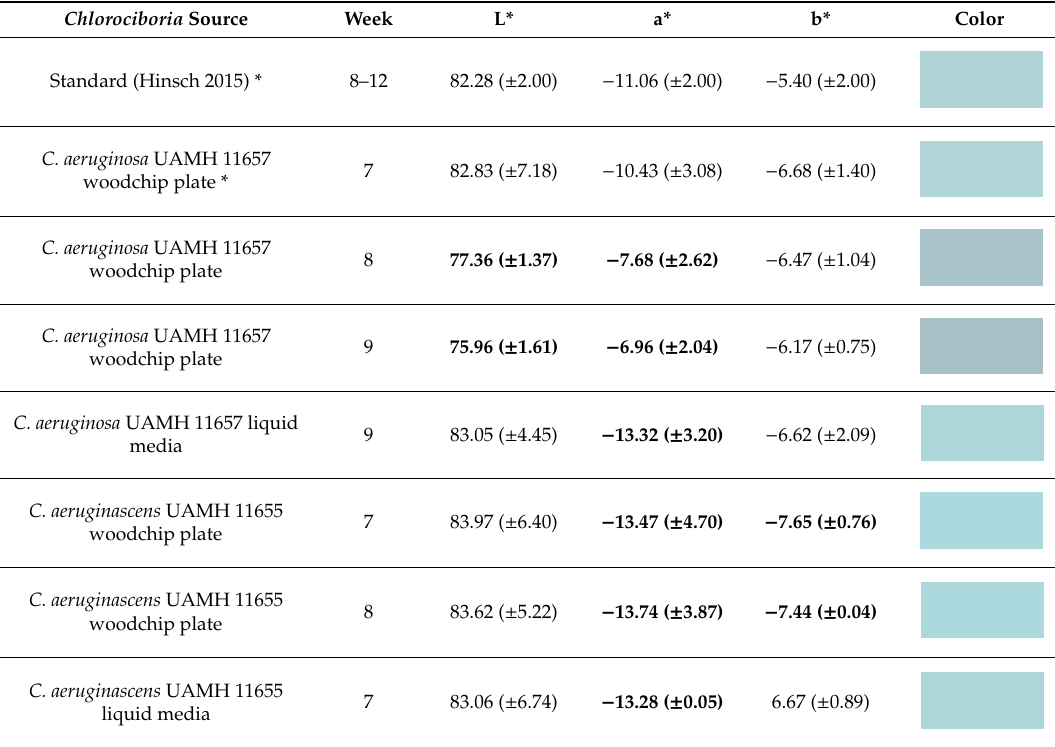
Table 2. Chlorociboria extraction colors with L* values matching or below standard. Extractions within the lab standard are denoted with an asterisk, and values out of range are in bold . Average color values of a* were seen to go out of range of standard, while L* and b* values conformed, apart from C. aeruginascens UAMH 11655 woodchip plate samples.